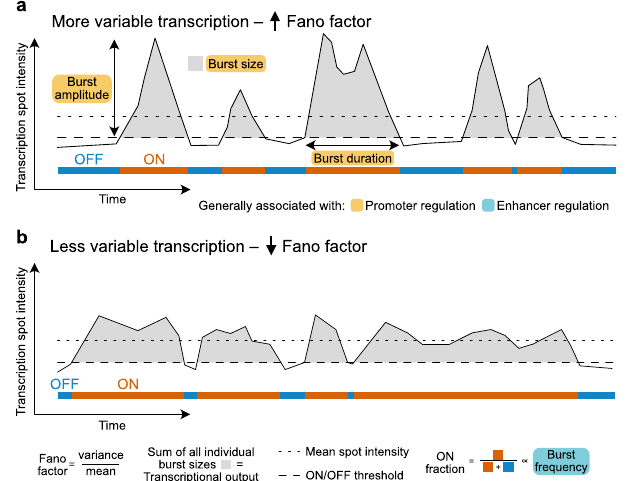
Fig. 1 | Schematic illustrating measurable features of transcription dynamics. Burst size changes are typically associated with promoter regulation, while burst frequency (ON fraction) is typically associated with enhancer regulation. More ( a ) and less ( b ) variable transcriptional activity traces of individual cells, with higher and lower Fano factor values, respectively, are illustrated. For highly expressed genes, burst frequency can be dif fi cult to measure directly from spot intensity traces. Measurement of ON fraction (similar to burst fraction in fi xed cells 35 ) in individual cells can be used to infer changes in burst